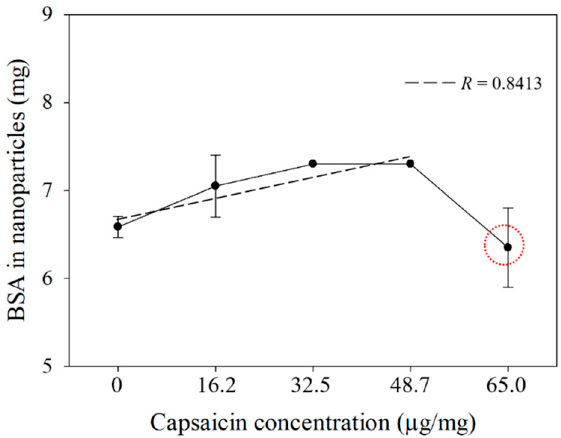
Figure 1. BSA protein transformed into nanoparticles as a function of capsaicin concentration. The quantified protein showed a linear tendency (R = 0.8413) in relation to the concentration. Values are means of three experimental replicates ± standard deviations.